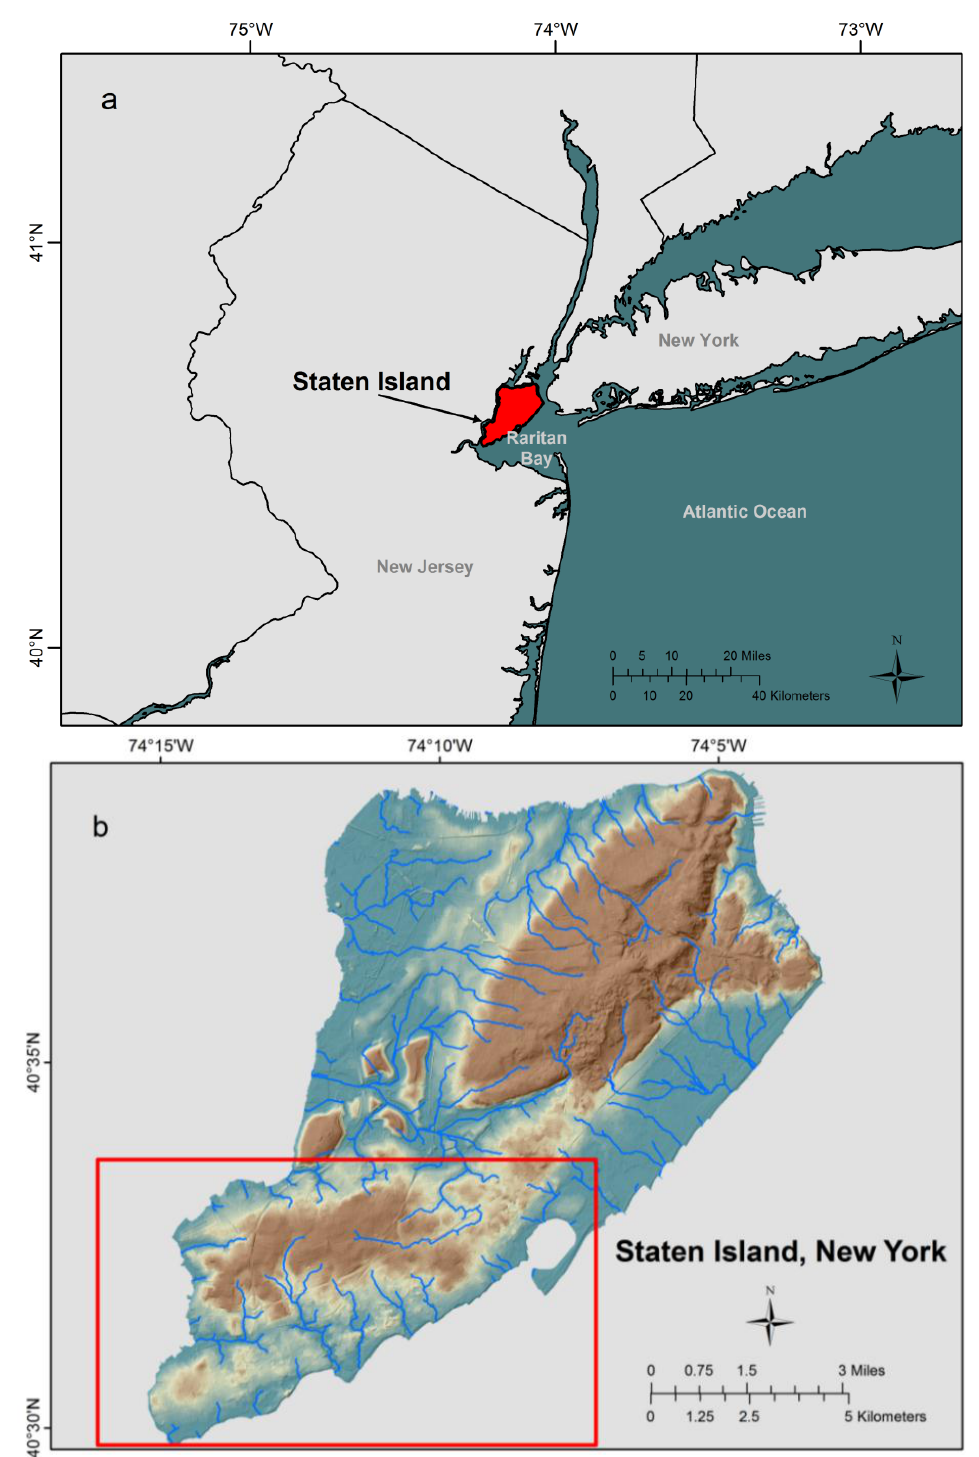
Figure 1. Study area of Staten Island, New York. ( a ) shows the location of Staten Island, New York. ( b ) shows the study area of Staten Island, New